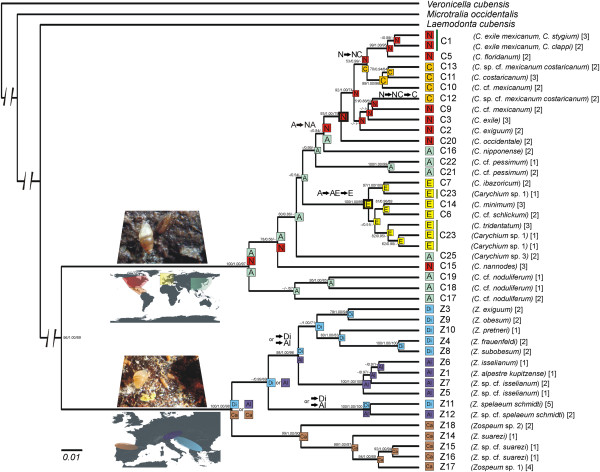
Phylogenetic hypothesis of Carychiidae. A consensus tree representing phylogenetic relationships of 22 Carychium and 16 Zospeum evolutionary lineages (EL) is illustrated. Statistical support is provided at the branches in the following order: Maximum Composite Likelihood bootstrap / Bayesian posterior probability / Maximum Likelihood bootstrap. For each EL, integrative decisions on the lineage assignments (see result section) and the number of individuals analyzed is given in brackets. Codes for the distribution and geographical range evolution are: North America (N; red), Central America (C; orange), Asia (A; cyan), Europe (E; yellow), Dinaric Alps (Di; blue), Alps (Al; purple) and Cantabrian Mountains (Ca; brown). Equally possible range scenarios are separated by an ‘or’. Arrows illustrate the directionality of range shifts. Geographic information and living specimens are shown at the branches giving rise to Carychium and Zospeum, respectively.